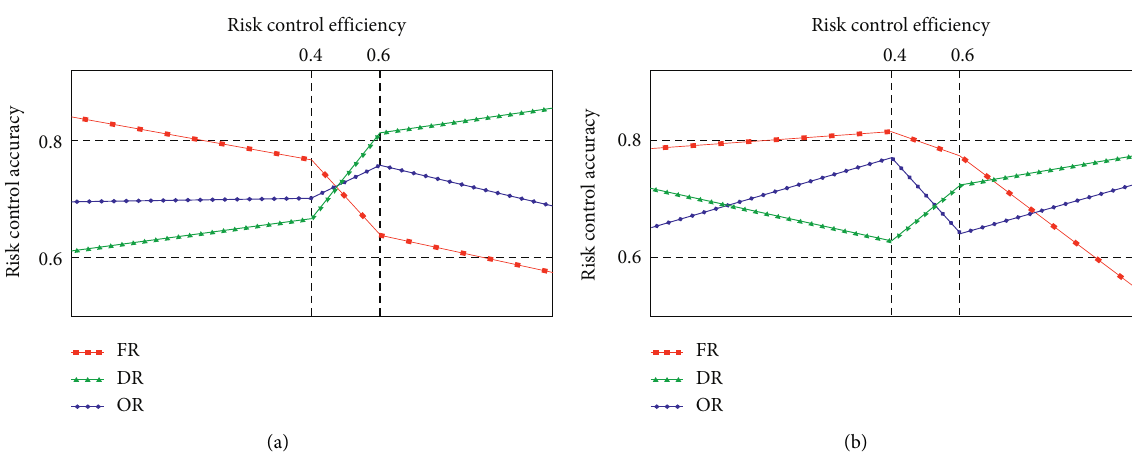
Figure 7: Relationship between risk control accuracy and efficiency of the foundation risk (FR), operation risk (DR), and disbandment risk (DR) of virtual enterprise under optimal allocation (a) and selective optimization